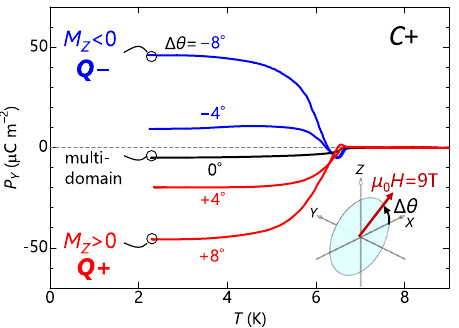
Fig. 5 Temperature dependence of P Y for the C + crystal in an applied μ 0 H of 9 T with Δ θ = 0, ±4°, and ± 8°. No electric fi eld was applied during each measurement as well as during a cooling process before each